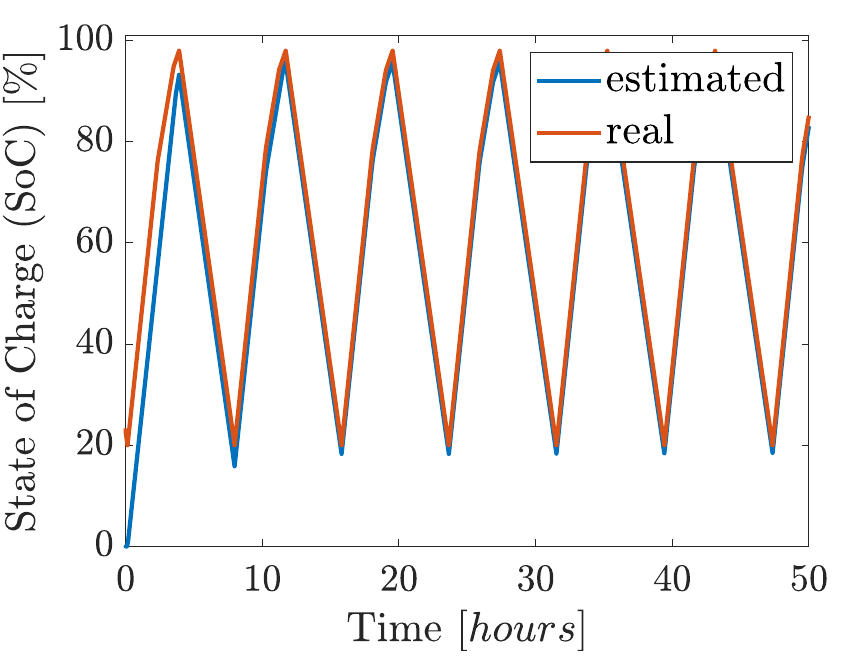
Figure 23. SoC estimation for the advanced SoC strategy.